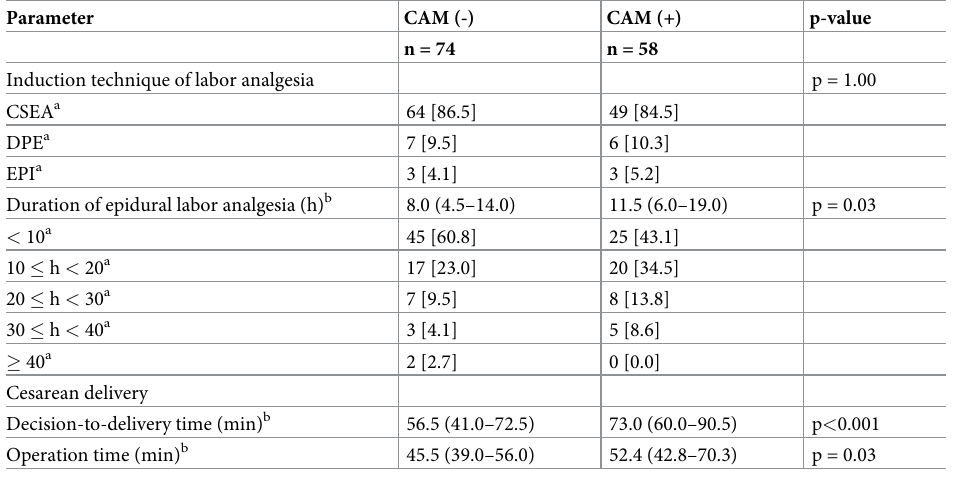
� 40 a 0 [0.0] Cesarean delivery Decision-to-delivery time (min) b 56.5 (41.0–72.5) 73.0 (60.0–90.5) p < 0.001 Operation time (min) b 45.5 (39.0–56.0) 52.4 (42.8–70.3) p = 0.03